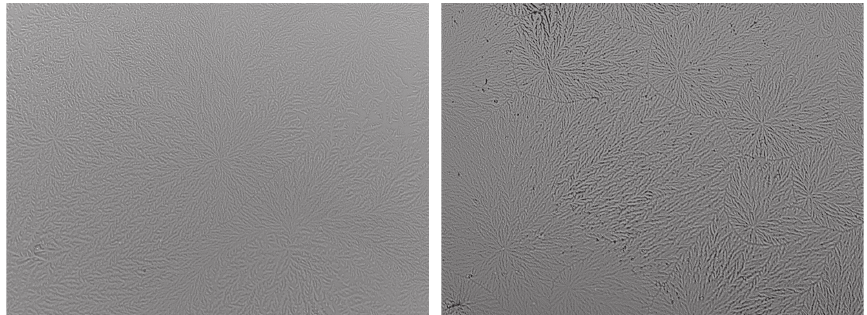
Figure 2: Representative TF images for two control group subjects.